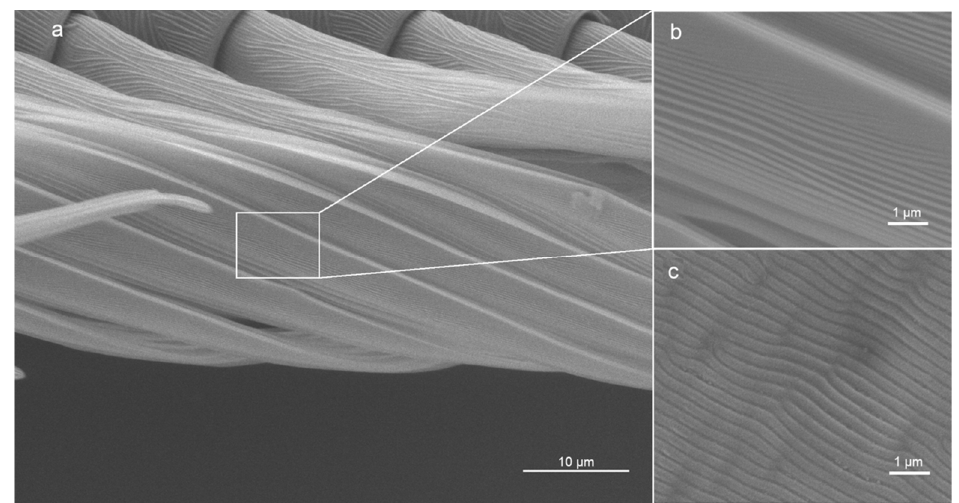
Figure 2. The nanostructures on the calamistrum were biomimetically replicated on PET via a nanosecond UV laser. ( a ) The calamistrum of the feather-legged lace weaver. ( b ) Nanoripples on the calamistrum. ( c ) LIPSS on PET foil. SEM images of gold-sputtered specimens.